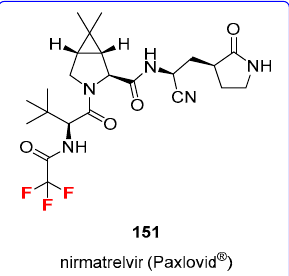
Figure 3. Chemical structure of nirmatrelvir ( 151 ).